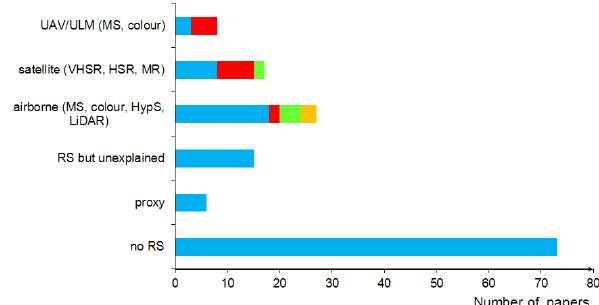
Figure 4. Use of remote-sensing devices for the purpose of terroir zoning from 2002 to March 2014. Source: Web of Science